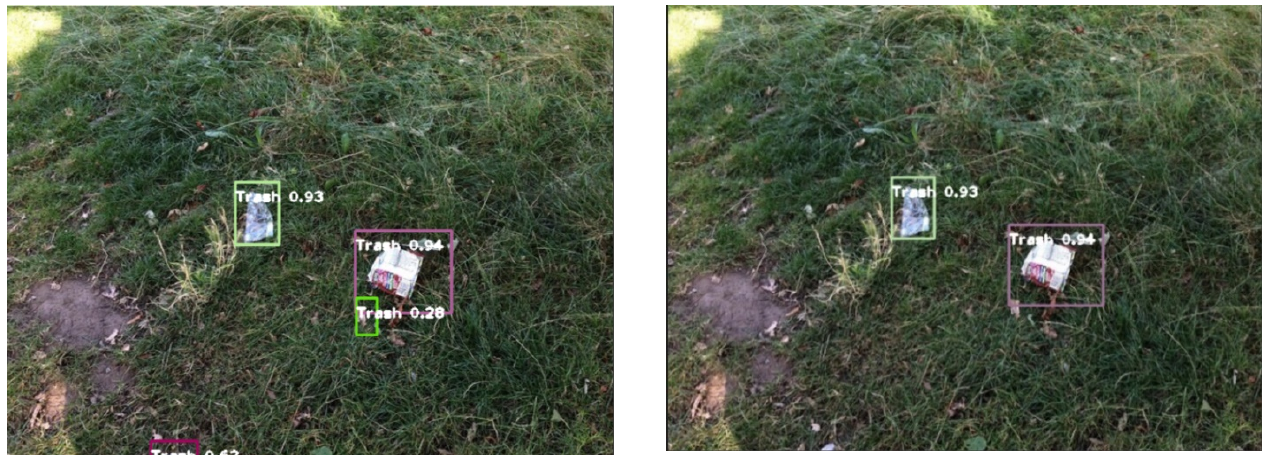
Figure 8. Trash detection using the custom YOLOv4-tiny model and trash detection using the YOLOv4-tiny model with